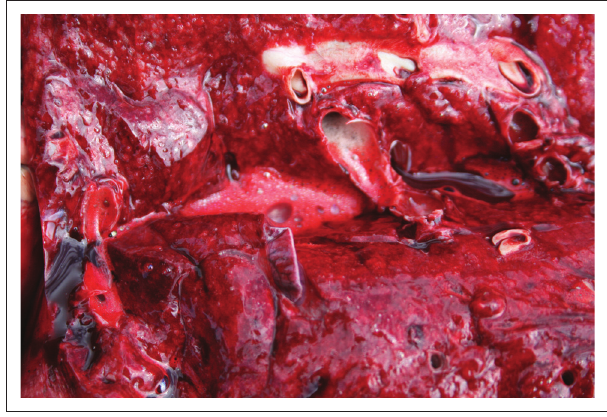
Source : Photo taken by R.G. Bengis FIGURE 5: Severe pulmonary oedema in a zebra following cyanobacterial intoxication.